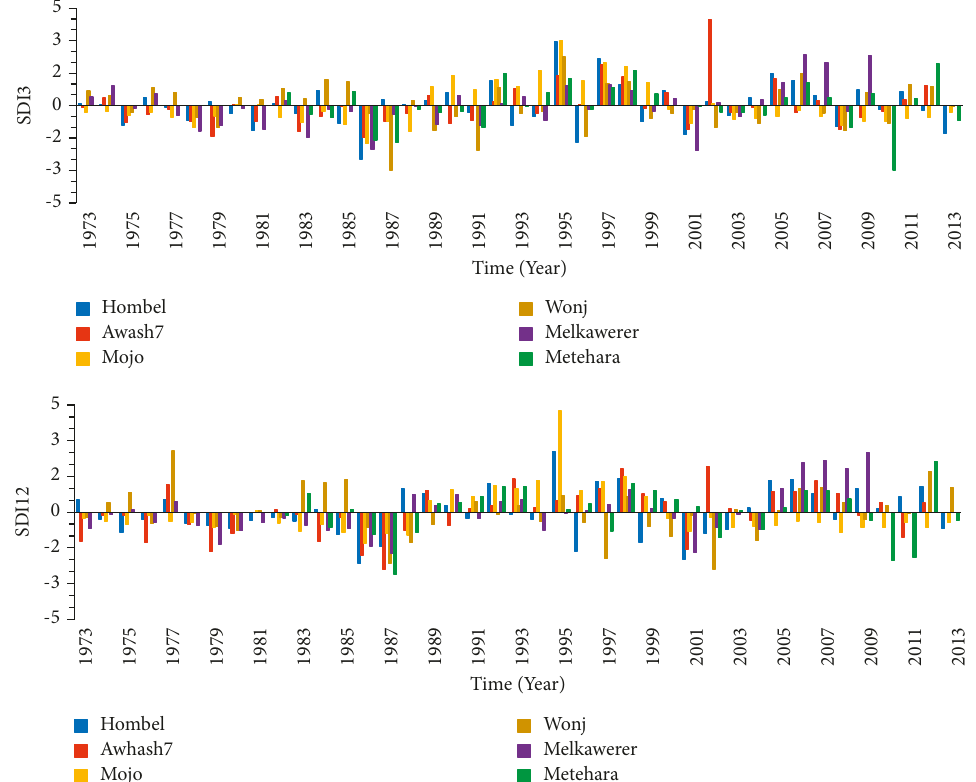
Figure 5: Temporal variation in seasonal (SDI3) and annual (SDI12) for Awash river